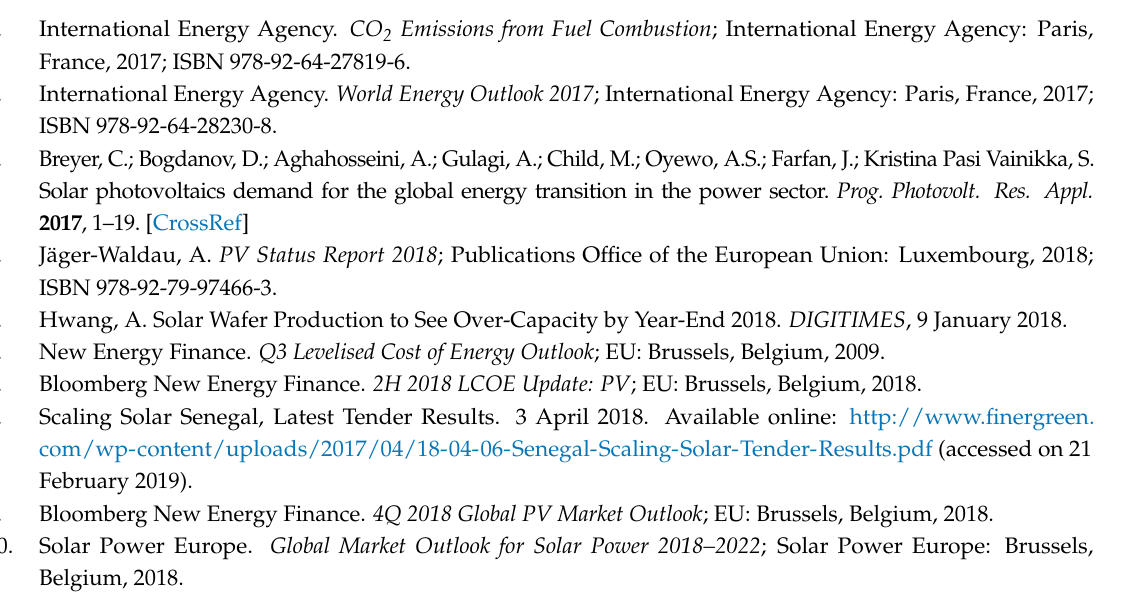
Greenpeace (reference scenario) Greenpeace (advanced [r]evolution